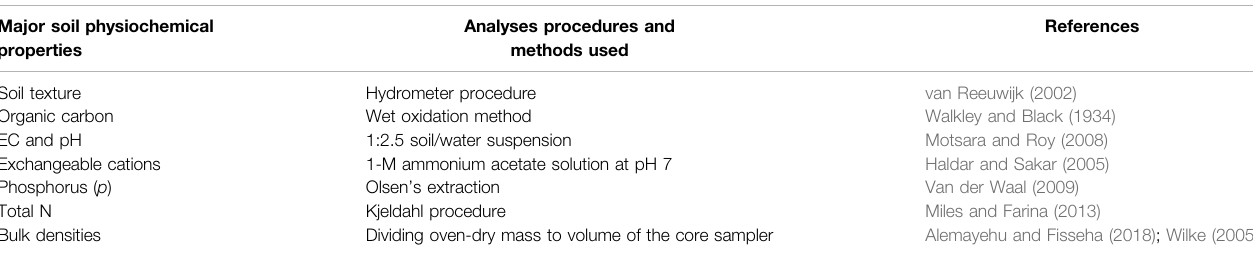
TABLE 1 | Standard procedures and methods used to analyses soil